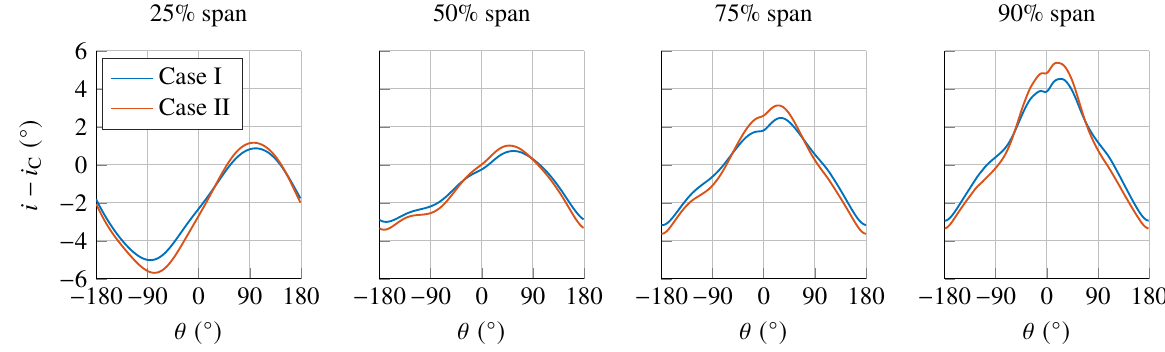
Figure 17. Circumferential variations of changes in the incidence angle relative to operation in the uniform flow at the propulsor inlet at various span fractions. Flow stagnates on the blade pressure surface with a positive incidence angle i